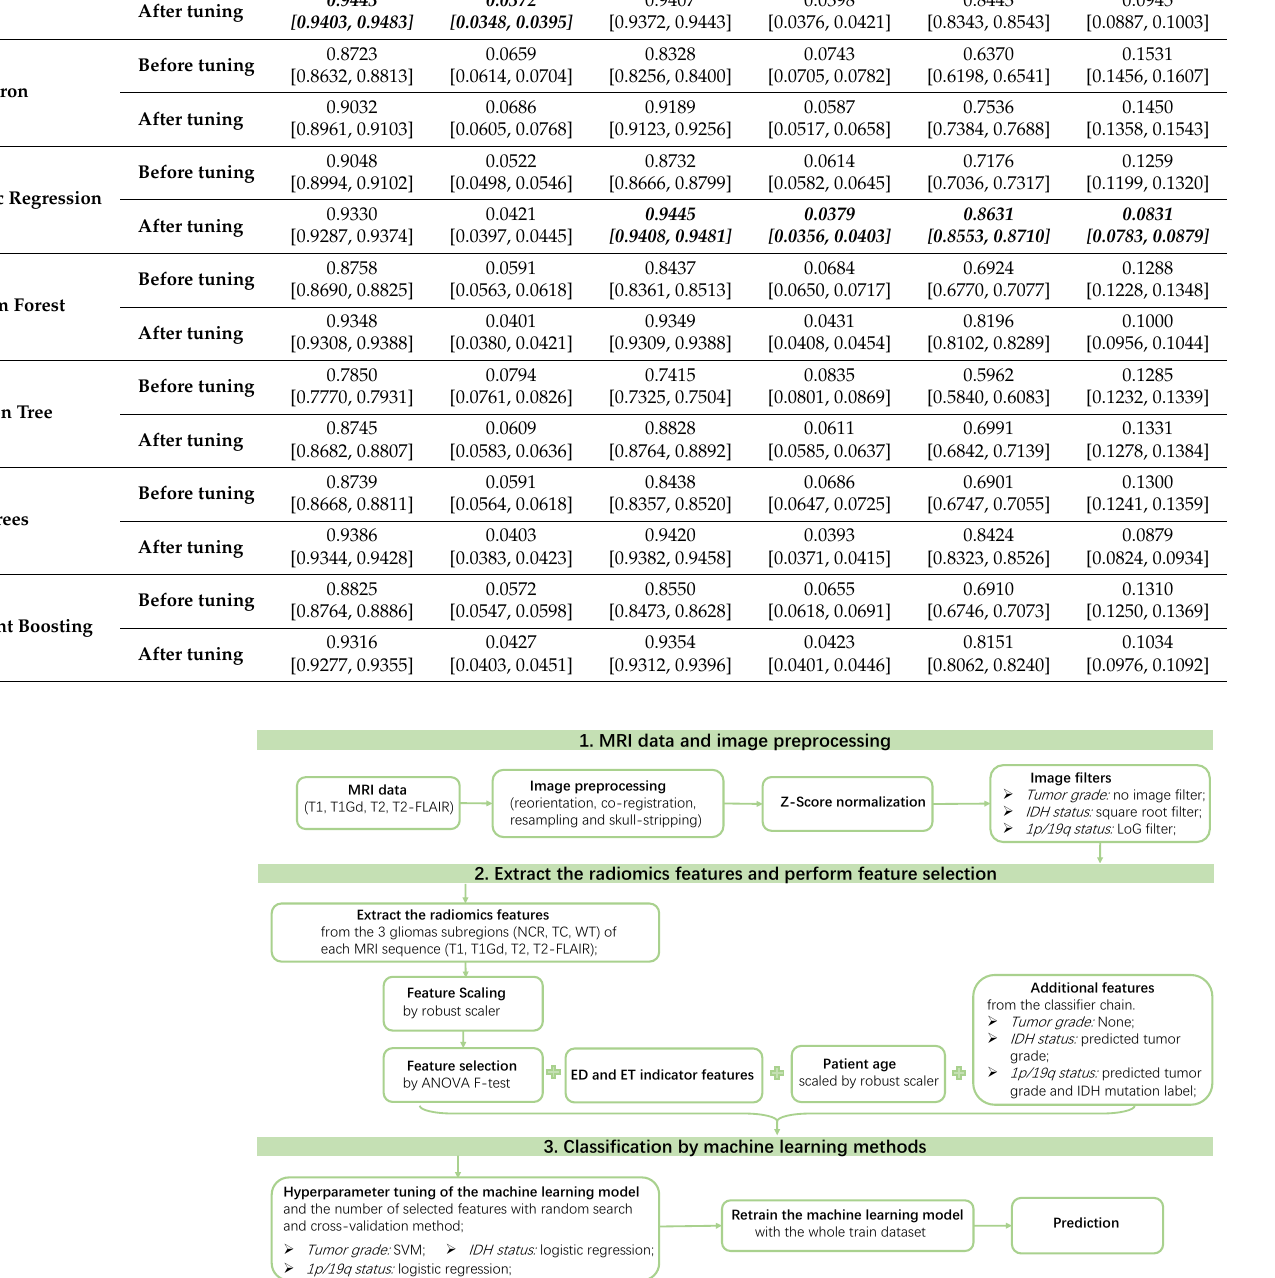
Figure 11. Final radiomics pipeline for predicting each binary classification label (tumor grade, IDH mutation status, and 1p/19q codeletion status) of the gliomas tumor. During the hyperparameter tuning process, the mean cross-validation AUC is used as the evaluation